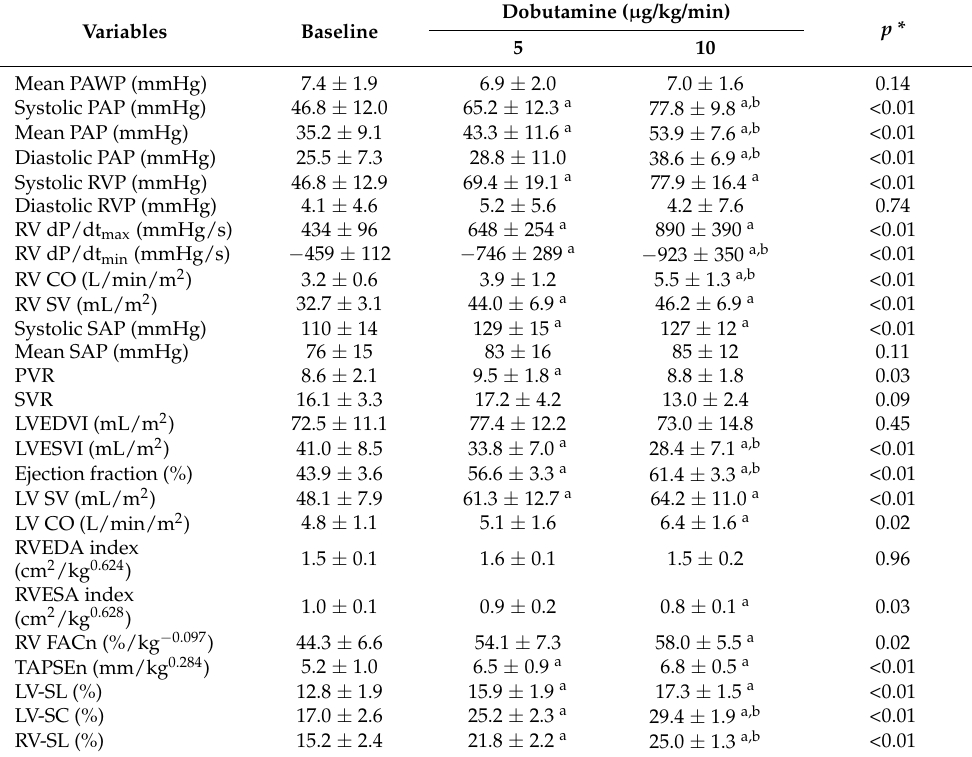
Table 2. Results of hemodynamic and echocardiographic variables before and after dobutamine